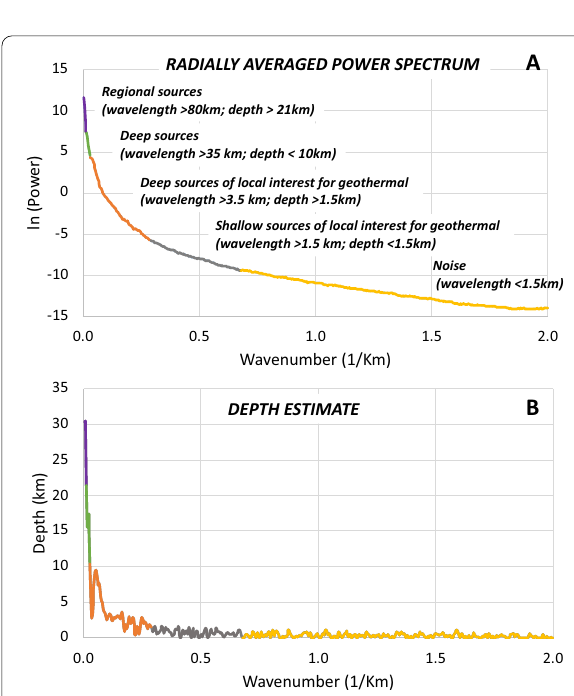
Fig. 8 A : Power spectrum of the regional CBA. B : depth estimation of the sources